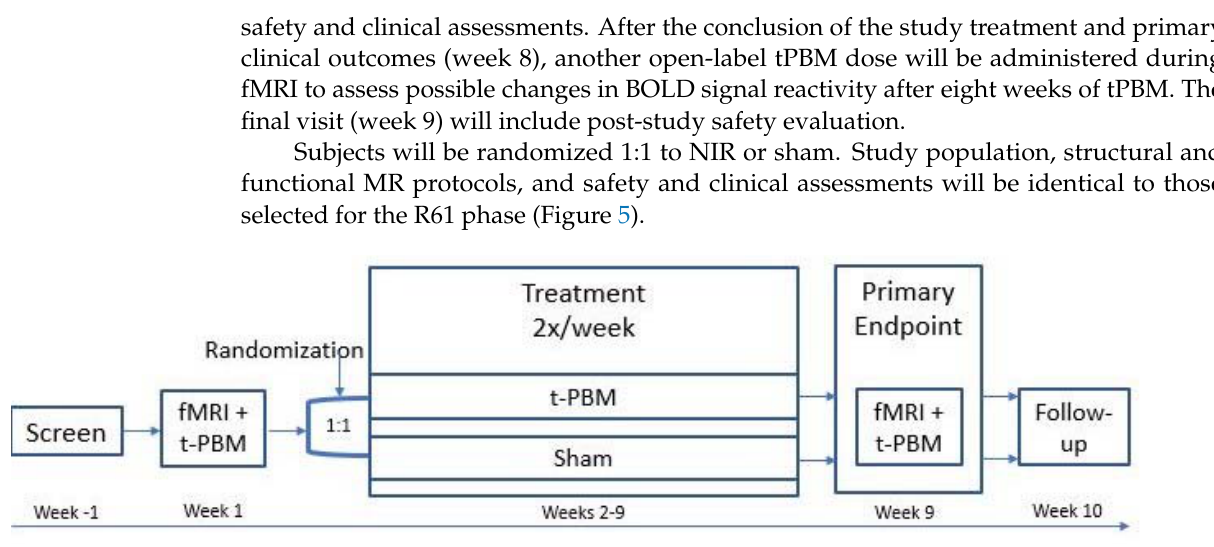
Figure 5. Schema of the R33 phase of the study.